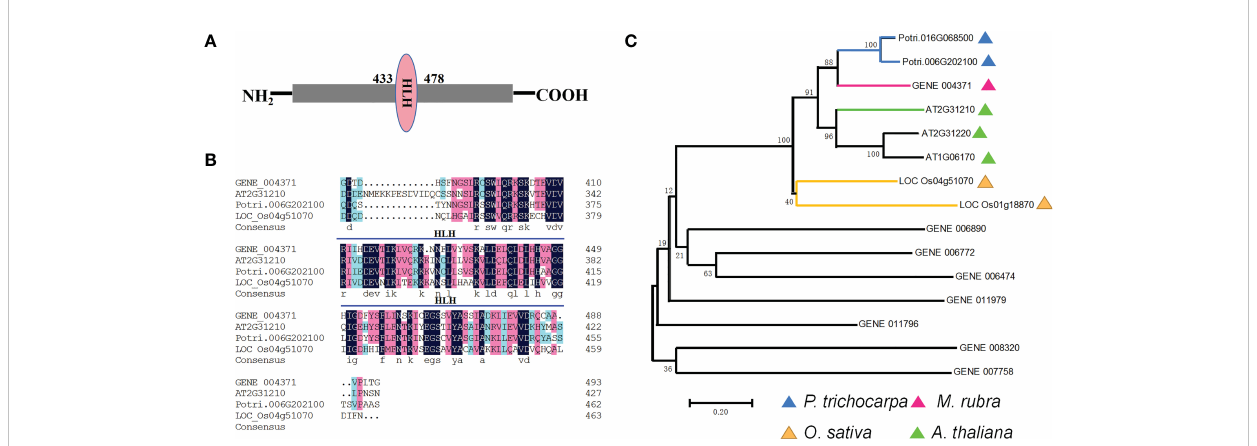
FIGURE 5 Bioinformatics analysis of bHLH gene (A) Domain architecture analysis of MrbHLH protein. (B) Multiple amino acid sequence alignment of bHLH10 from M. rubra , O. sativa , P. trichocarpa and A . thaliana . (C) Phylogenetic analysis of bHLH homologs from M. rubra , O. sativa , P. trichocarpa and A . thaliana . Scale bars,